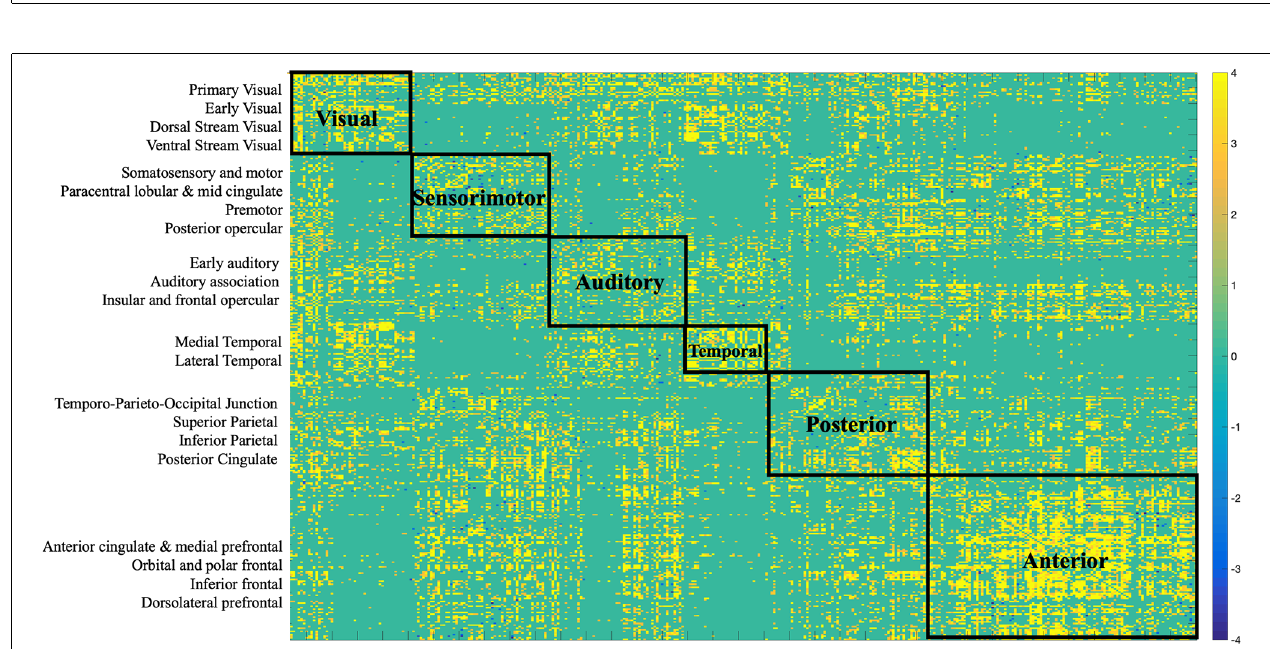
FIGURE 5 | Behavioral saliences, with confidence intervals from bootstrap resampling. Error bars indicate bootstrapping 5th to 95th percentiles. Abbreviations: MRI1, at first MRI scan; MH MR1, Mill Hill Vocabulary Test; SRT MRI1M, mean performance of Simple Reaction Time; MDA MRI1, Matrices Task with position recall; MAT MRI1, Matrices Task with word position recall; CL6 MRI1, mean performance on Letters Comparison Task with six letters; CL9 MRI1, mean performance on Letters Comparison Task with nine letters; RAVEN MRI1, Raven Progressive Matrices 38; CL6 MRICV, Coefficient of variation of Letters Comparison Task with six letters; CL9_MRI1CV, Coefficient of variation of letters comparison Task with nine letters; Stroop MRI1, Color Stroop Task.